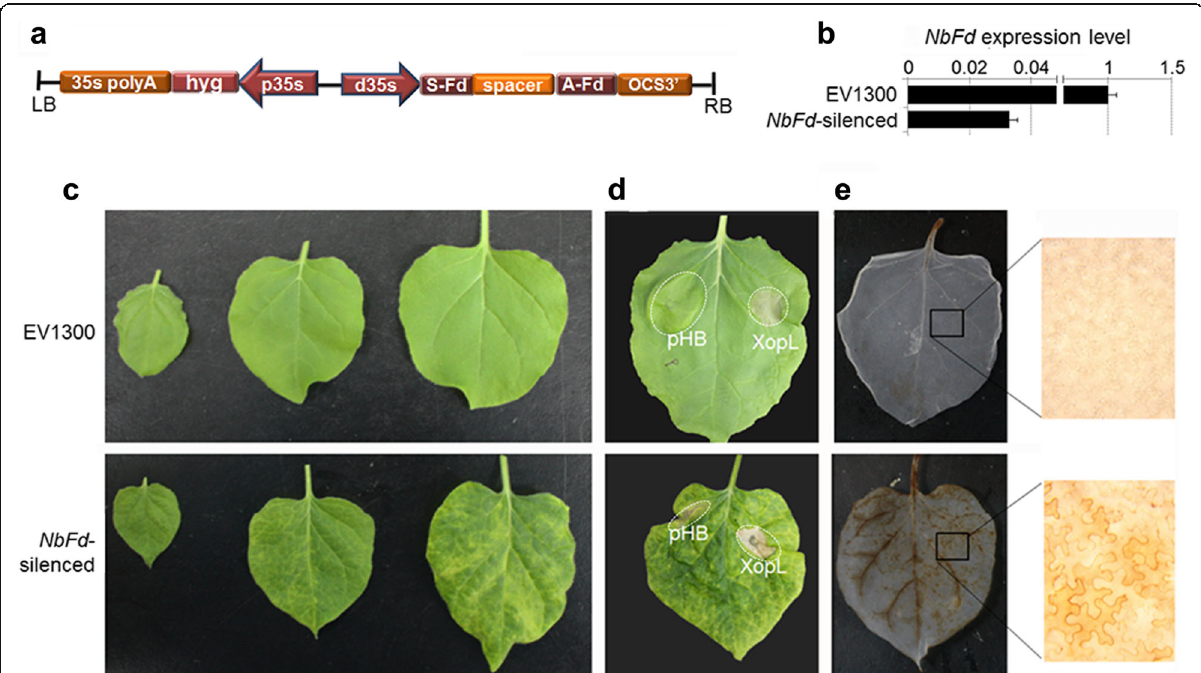
Fig. 5 Characteristics of NbFd -silenced plants. a Schematic representation of construct used for RNAi-mediated silencing of NbFd . S-Fd, 22 – 422 bp of NbFd coding region, sense orientation; A-Fd, 22 – 422 bp of NbFd coding region, antisense orientation. b qRT-PCR analysis of NbFd expression levels in 4-week-old NbFd -silenced and control (EV1300, empty vector transgenic) plants. Values represent mean ± SD ( n = 3). EF1 α was used as a reference gene. c Phenotypes of EV1300 and NbFd- silenced plants. The three uppermost leaves were photographed from representative EV1300 and NbFd- silenced plants. d Cell death on leaves of EV1300 and NbFd- silenced plants in response to XopL and pHB. Agrobacterium strains